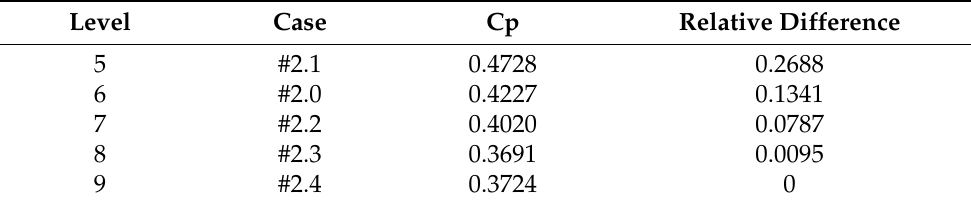
Figure 18. Cp time evolution for cases #2.0 (blue), #2.1 (red), #2.2 (green), #2.3 (pink) and #2.4 (cyan). Table 5. Summary of the Cp values after 1 s of simulation depending on the level of refinement on the blades. The relative difference compared to the level 9 simulation is given in the last